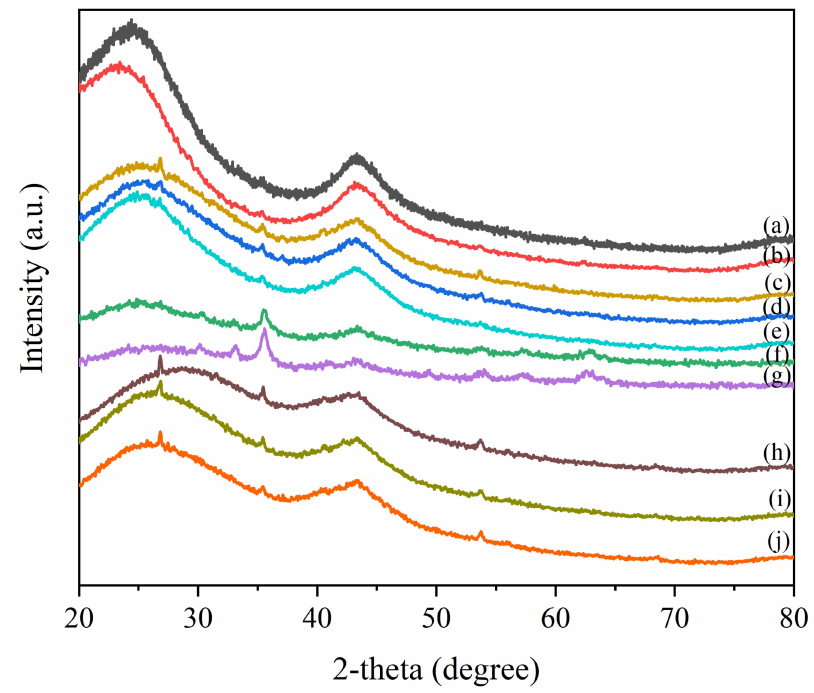
Figure 1. XRD pattern of Pt-based catalyst: (a) AC, (b) Pt/AC, (c) 0.1FePt/AC, (d) 0.15FePt/AC, (e) 0.2FePt/AC, (f) 5FePt/AC, (g) 10FePt/AC, (h) 0.15CoPt/AC, (i) 0.15NiPt/AC, and (j)